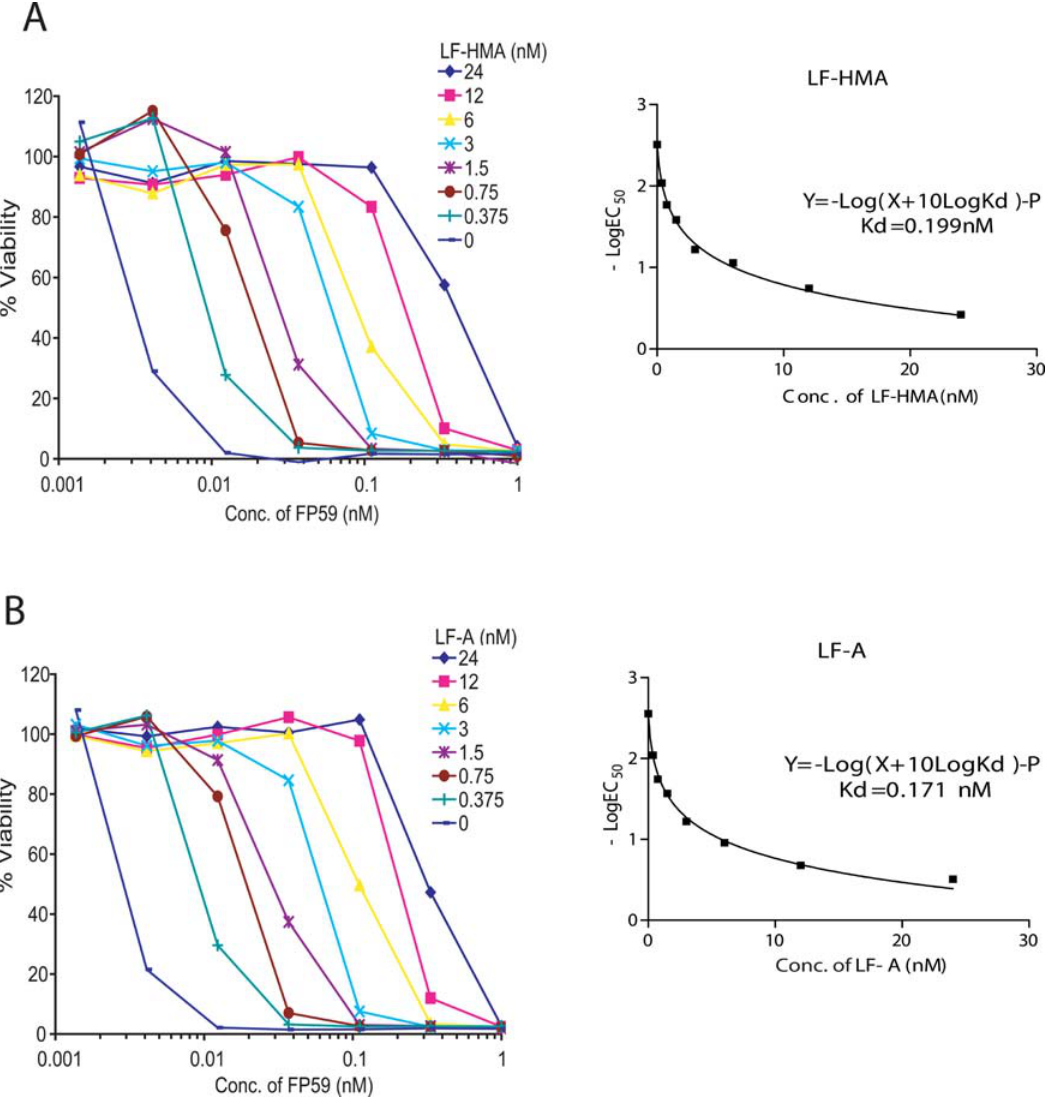
Figure 4. Evaluation of the apparent binding affinities of LF-HMA and LF-A for PA using Schild Plot analyses. CHO WTP4 cells were incubated with various concentrations of FP59 plus a set concentration of PA (12 nM) and different concentrations of LF-HMA (A) or LF-A (B) for 3 h. After toxin removal, cells were incubated with the toxin-free medium containing 10 mM NH 4 Cl for 48 h before assessment of cell viability. Schild Plot analyses were performed as described in ‘‘Methods’’ to assess K d s of each LF protein for PA. Inserts shown in panels A and B are non-linear regression curves obtained from these analyses using GraphPad Prism.